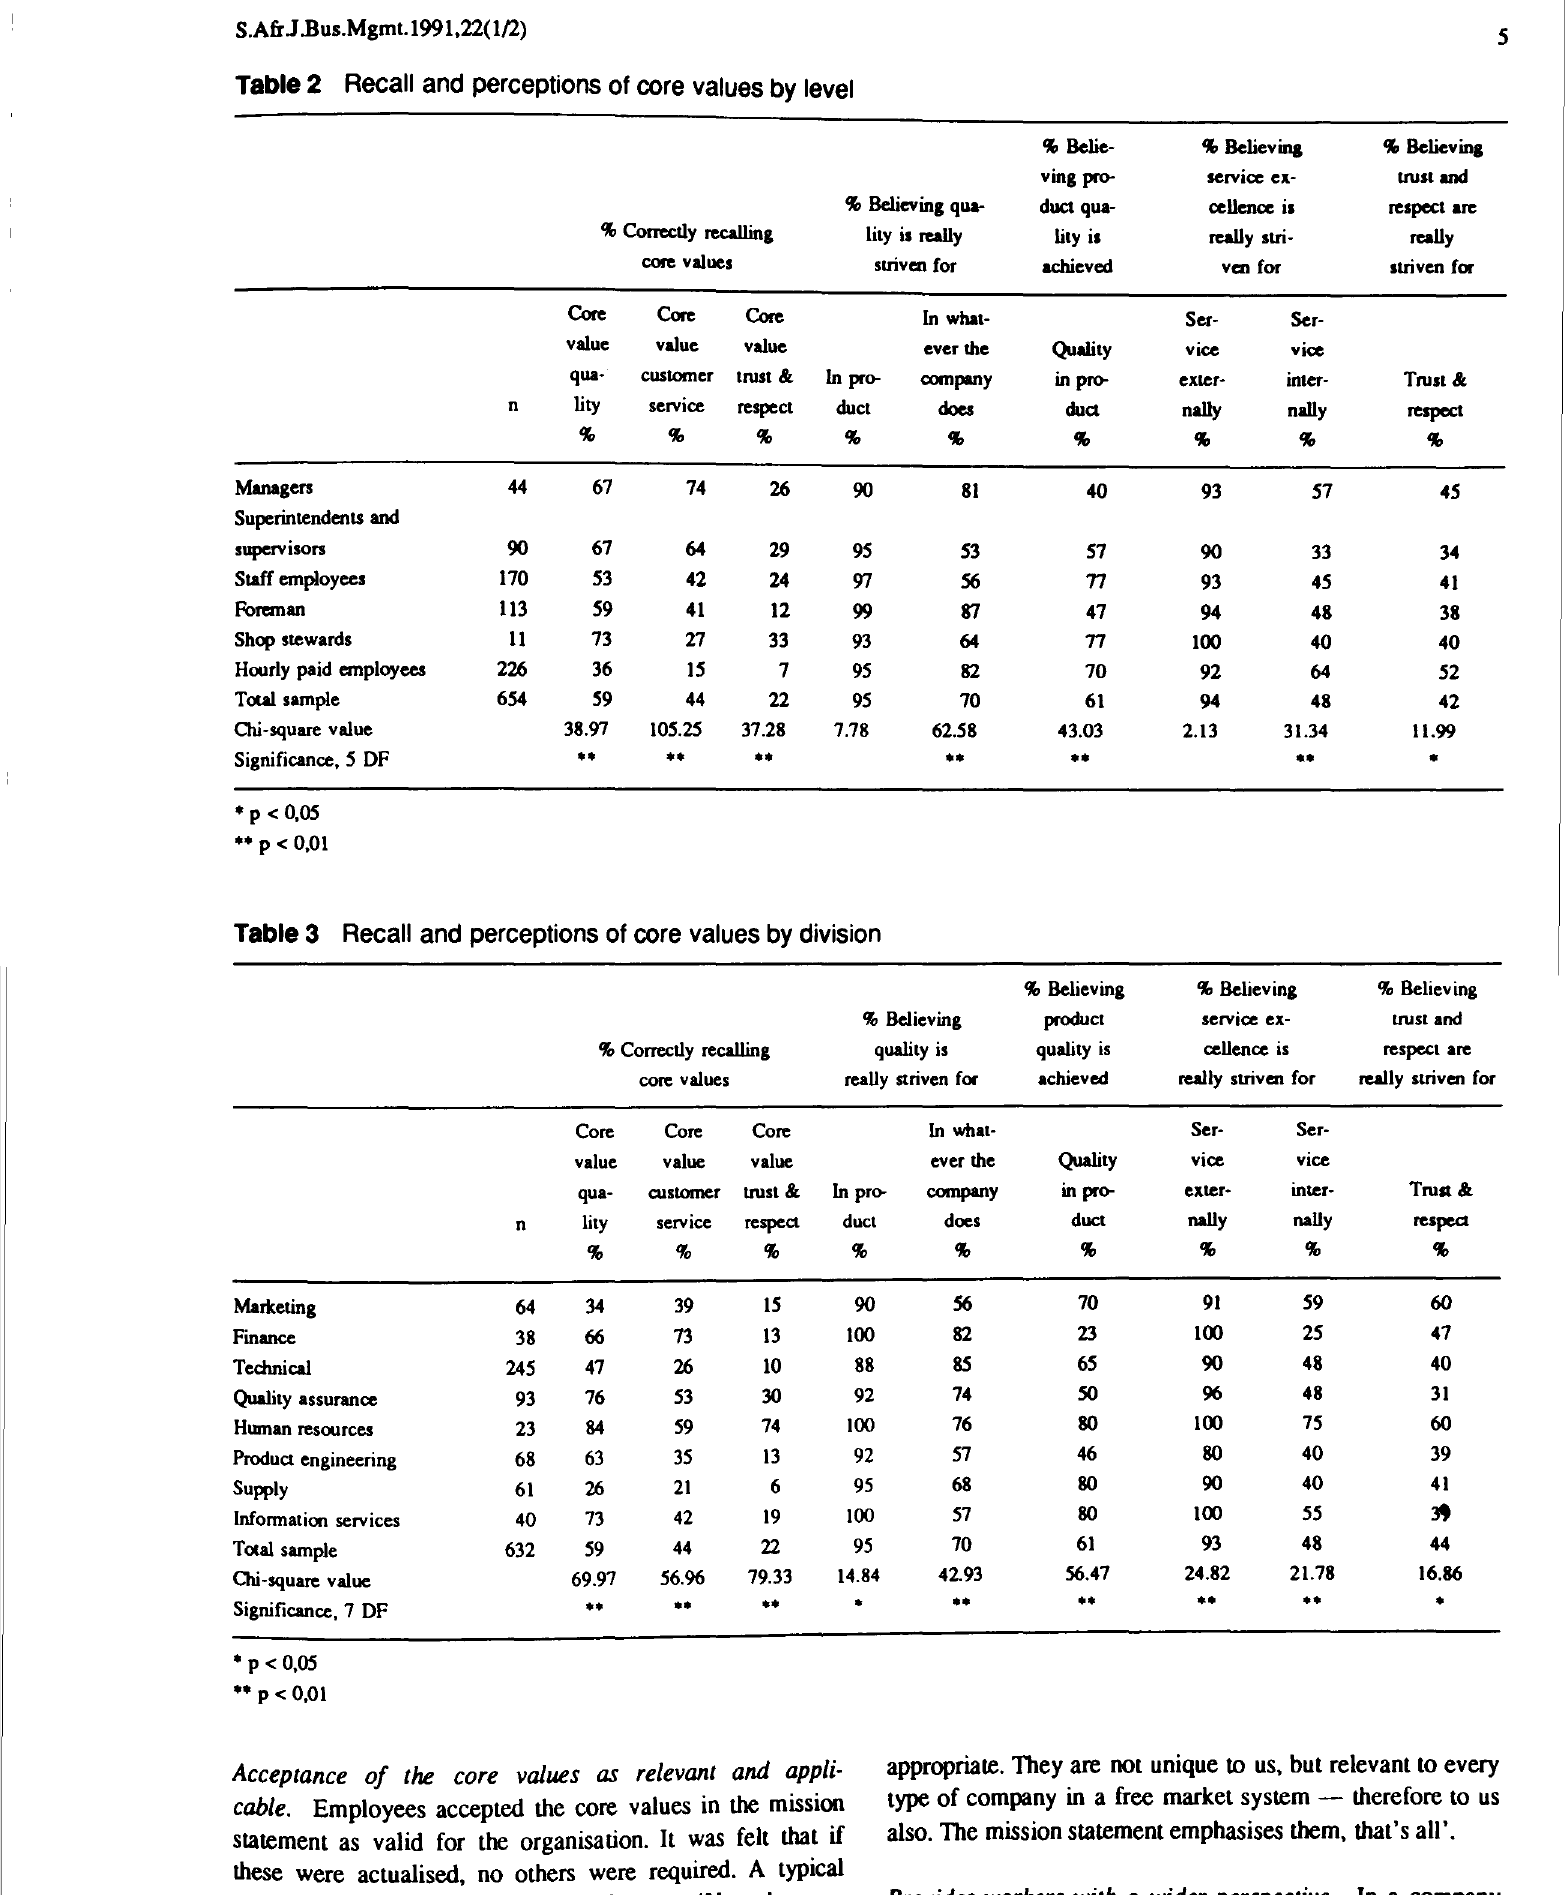
Table 3 Recall and perceptions of core values by